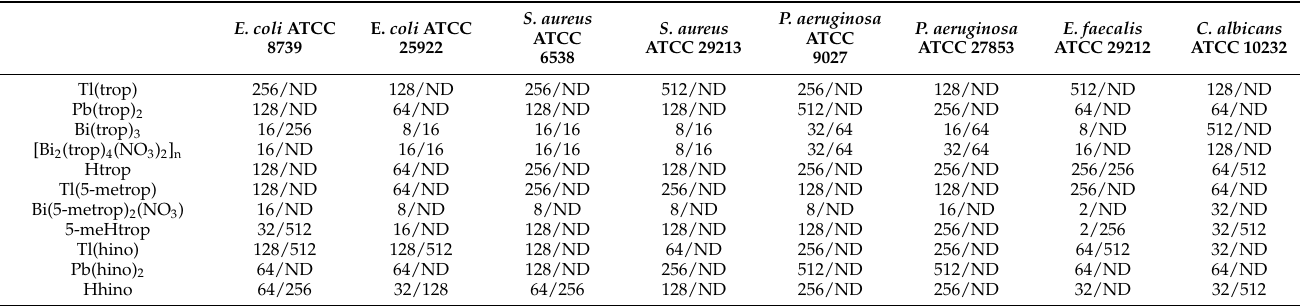
Table 6. MICs/MBCs * or MFCs * of thallium(I), lead(II), and bismuth(III) complexes and free ligands obtained for reference